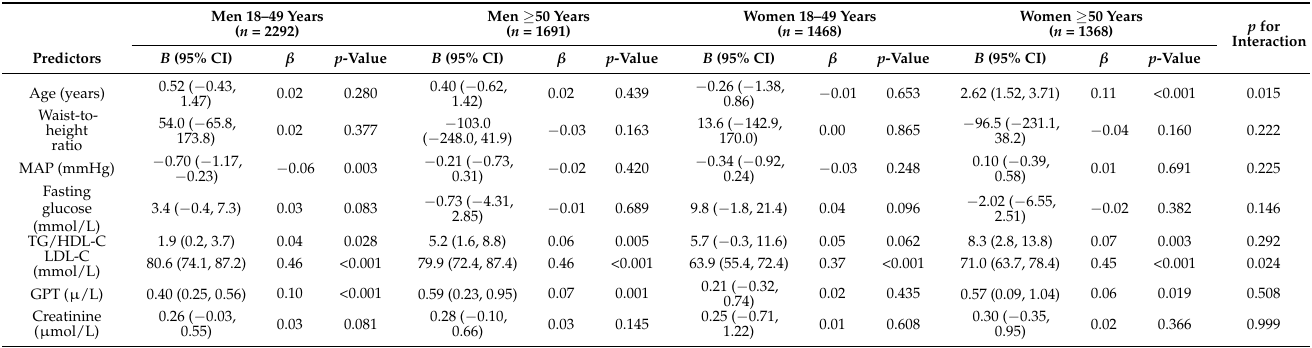
Table 6. Multivariable linear regression for the associated factor of Lp-PLA2 level by sex and